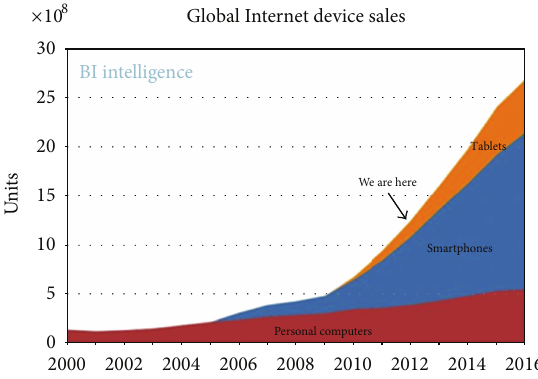
Figure 7: Global Internet device sales.